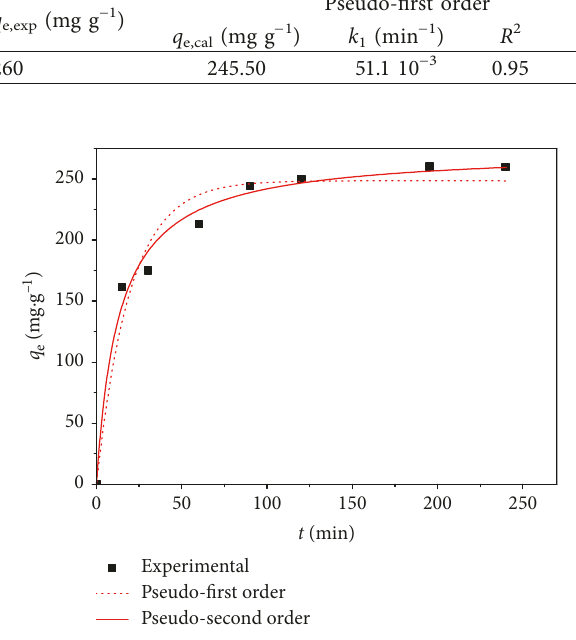
Figure 9: Nonlinear fits of pseudo-first-order and pseudo-second- order kinetics for methylene blue adsorption onto activated carbon.